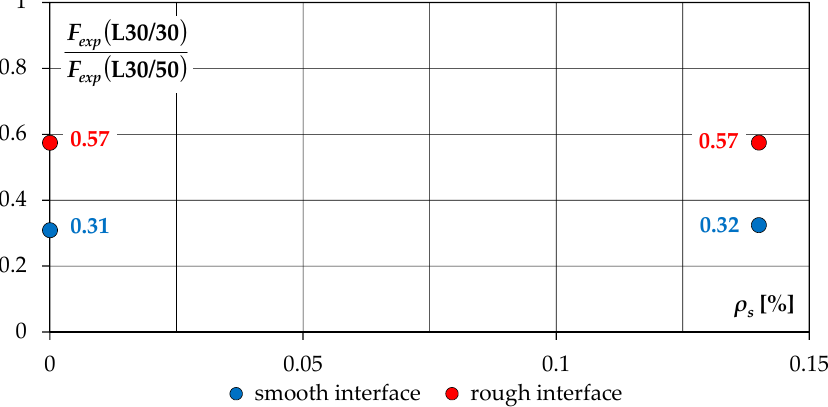
Figure 19. Comparison between experimental loads of the L30/30 and L30/50 series specimens.